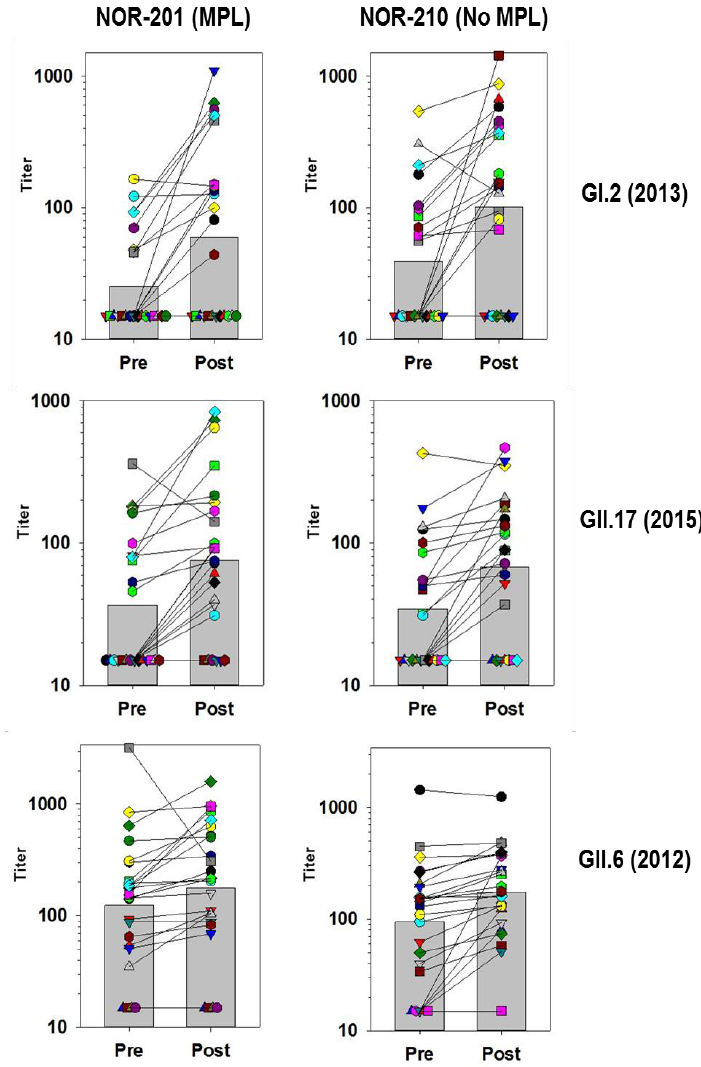
Figure 2. Blockade Titers Specific for GI.2 (2013), GII.17 (2015), and GII.6 (2012) measured in individual sera before and after vaccination with TAK-214 in the NOR-201 and NOR-210 clinical trials. The subjects tested from NOR-201were given vaccine that contained MPL adjuvant and subjects in NOR-210 received vaccine without MPL. Individual subjects are different colors and matched sera results are connected by solid lines. The bars in the background represent the geometric mean titer of the subjects. Samples below the assay lower limit of quantitation of 30 are assigned a value of 15.